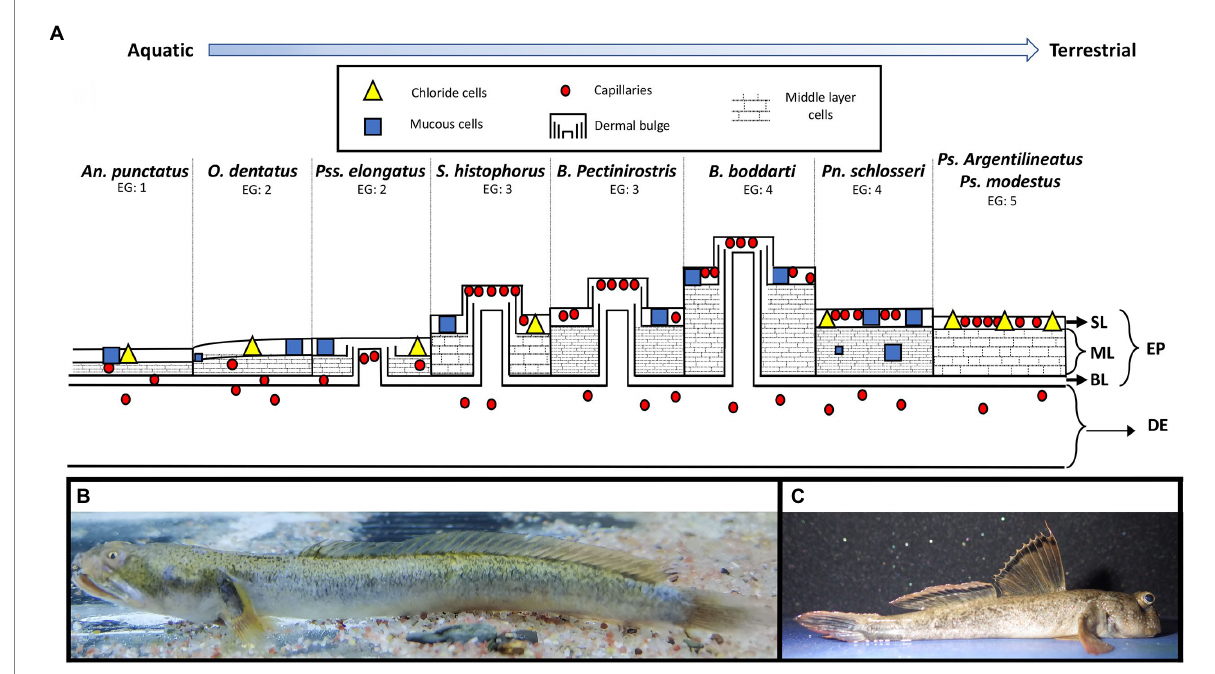
FIGURE 1 (A) Schematic representation of the variation in histological features from the head of mudskipper species representing different emission groups from fully aquatic (emersion group EG1) (left) to highly terrestrial (EG5) (Right). Layers include the dermis (DE) and epidermis (EP), which included a superficial layer (SL), middle layer (ML), and basal layer (BL). Figure modified from Zhang (2001). Morphological variation between EGs can be seen between (B) , Oxuderces dentatus (EG2) collected in Panyu, Guangdong Province, China, in September 2022 (Photo credit: Minzheng Li) and (C) , Periophthalmus magnuspinnatus (EG5) (not used in this study, but representative of the “P clade” in figure 2) collected from the Bohai Sea, China, in July 2016 (Photo credit: Joel B.